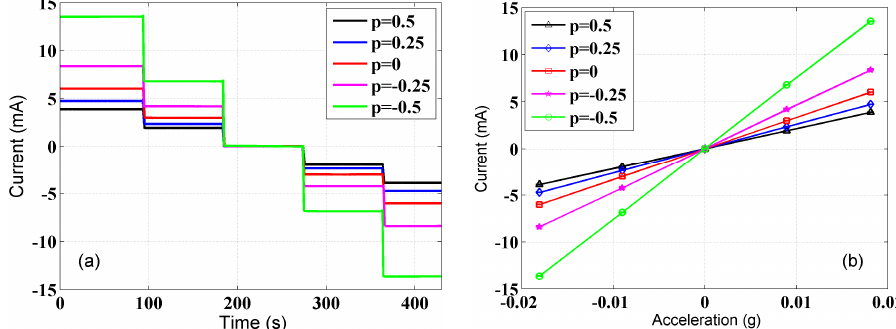
Figure 4. Calibration results of the scale factor of the trimmed accelerometer. ( a ) The output of the trimmed accelerometer with different proportional coefficient p . ( b ) The output of the trimmed accelerometer varies with changes in acceleration, and the slope of each line is the scale factor of the trimmed accelerometer corresponding to the proportional coefficient p . The standard deviation of each current step is at the order of 0.01 mA.